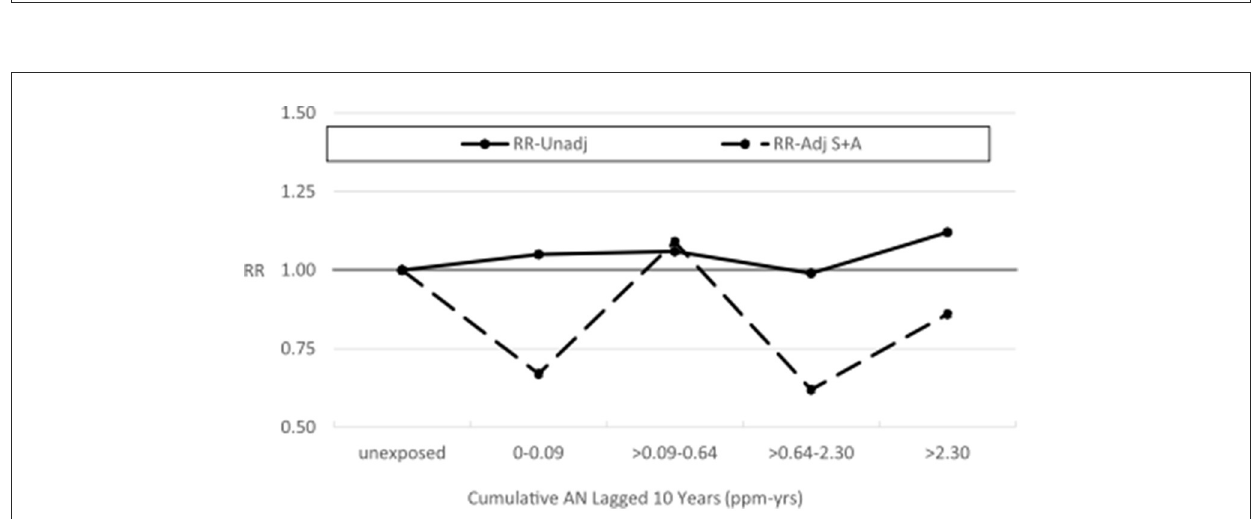
FIGURE6 UPitt lung cancer relative risks (RR) by cumulative AN exposure, unadjusted and adjusted for confounding by smoking (S) and by asbestos (A) using the Richardson method, omitting Plant